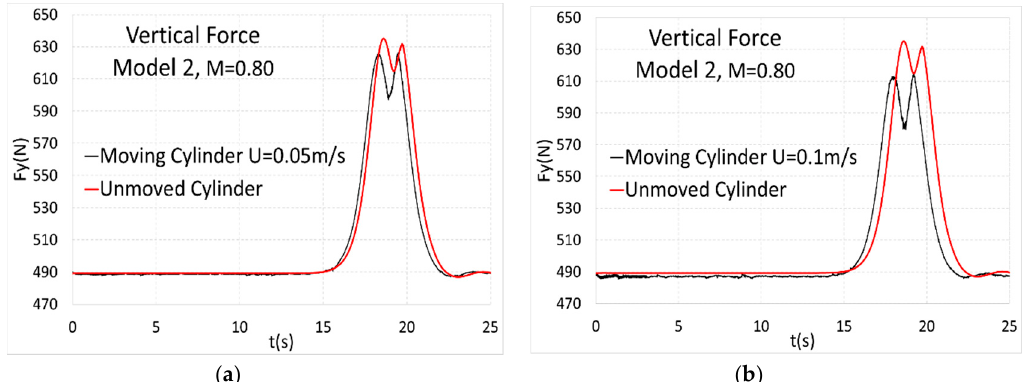
Figure 15. The time variation of vertical forces for model 2. ( a ) The comparison between the unmoved cylinder (red line) and the moving cylinder at U c = 0.05 m/s. ( b ) The comparison between the unmoved cylinder (red line) and the moving cylinder at U c = 0.1 m/s.